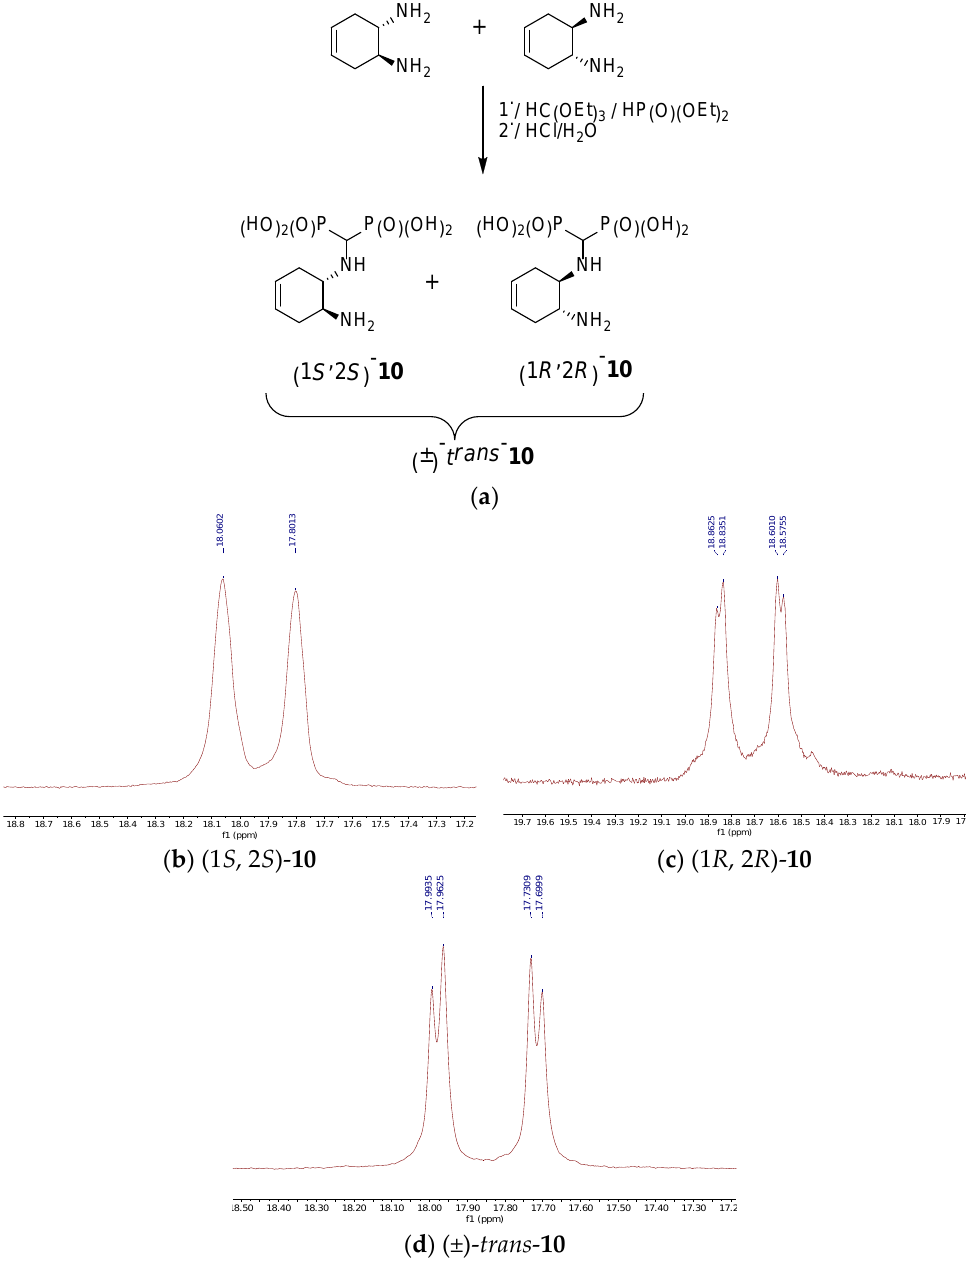
Figure 6. Isomers of trans -4-cyclohexene-1-amino-2-aminomethylenebisphosphonic acid ( a ) and representative 31 P NMR spectra of these compounds ( b – d ).